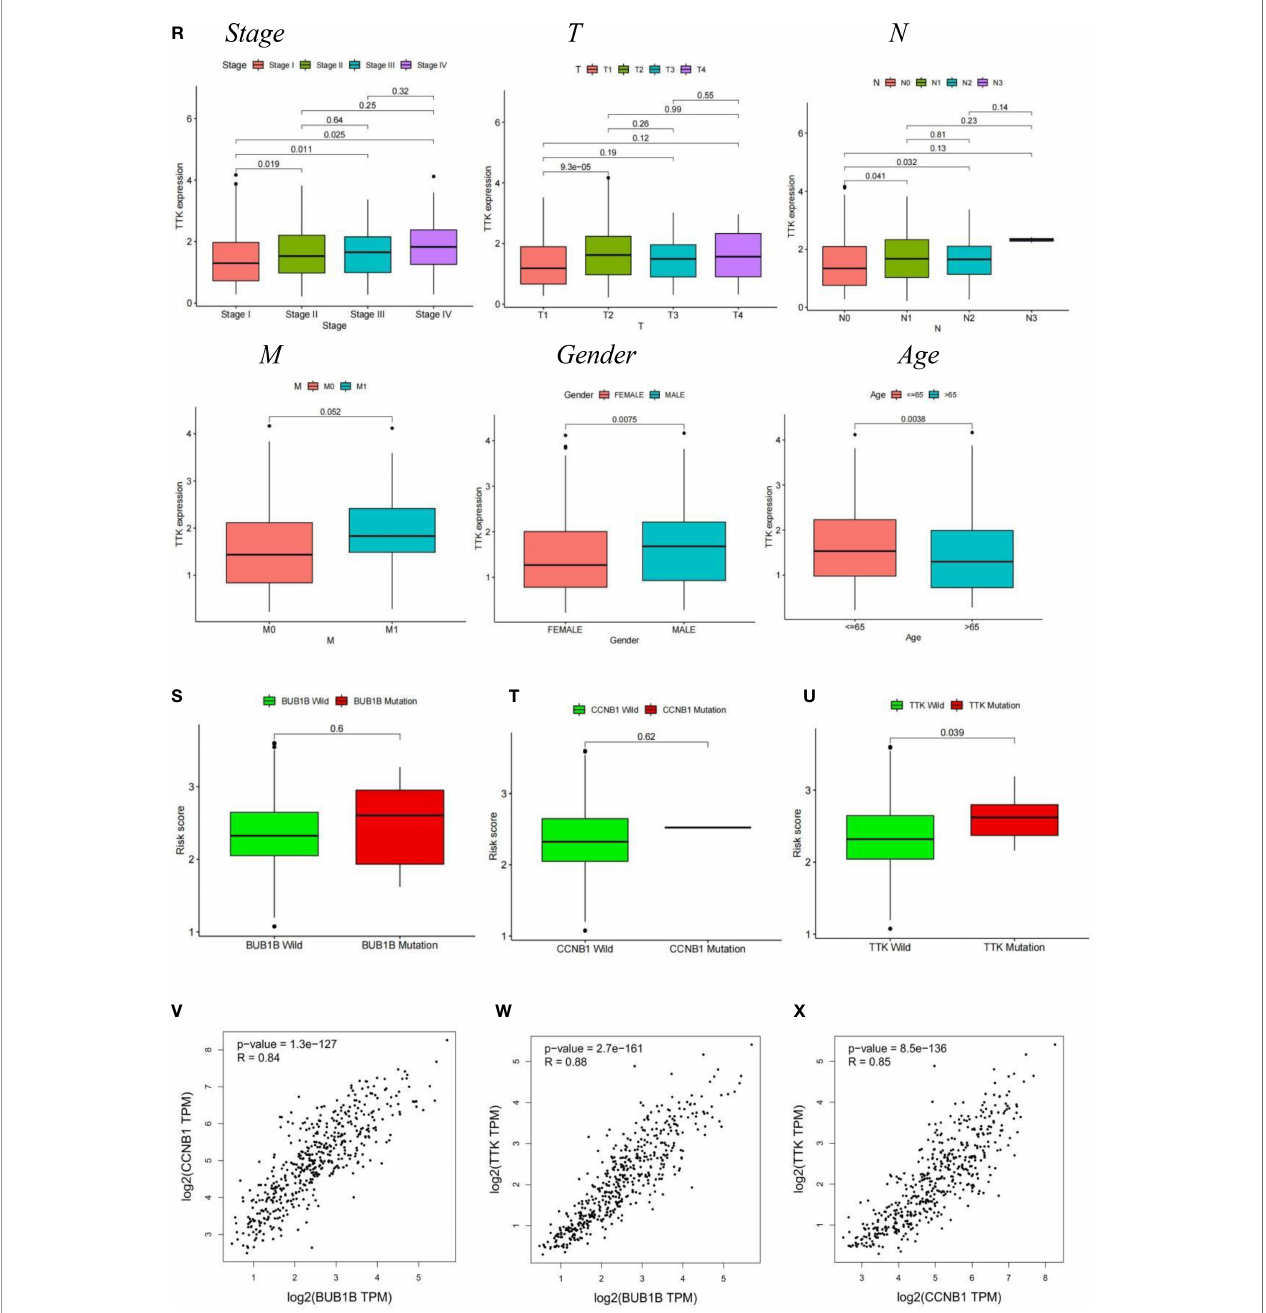
FIGURE 5 | (A) PPI network of risk differential genes. (B, C) Top 10 hub genes of the gene expression network. (D – F) Comparison of BUB1B (D) , CCNB1 (E) , and TTK (F) mRNA expression levels of each gene in LUAD tissue and normal lung tissue. The expression levels of all genes in cancer tissues were higher than those in normal lung tissues. The red and blue boxes represent tumor and normal tissue, respectively. Red asterisks indicate signi fi cant differences in the expression of each mRNA (p-value < 0.05). (G – L) OS and RFS of 3 target genes of BUB1B (G, H) , CCNB1 (I, J) , and TTK (K, L) . (M – O) Immune cell content of 22 immune cell types in BUB1B (M) , CCNB1 (N) , and TTK (O) Hub genes. (P – R) The relationship of BUB1B (P) , CCNB1 (Q) , and TTK (R) target genes and clinicopathological features, including TNM stage (Stage), tumor invasion (T) , lymphoid metastasis (N), distal metastasis (M) , gender (Gender), and age (Age). (S – U) Correlation analysis between the type of gene mutation (mutant, wild type) and risk score, BUB1B (S) , CCNB1 (T) , and TTK (U) . (V) BUB1B and CCNB1 correlation analysis. (W) BUB1B and TTK correlation analysis. (X) CCNB1 and TTK correlation analysis. *p < 0.05, **p < 0.01, ***p <